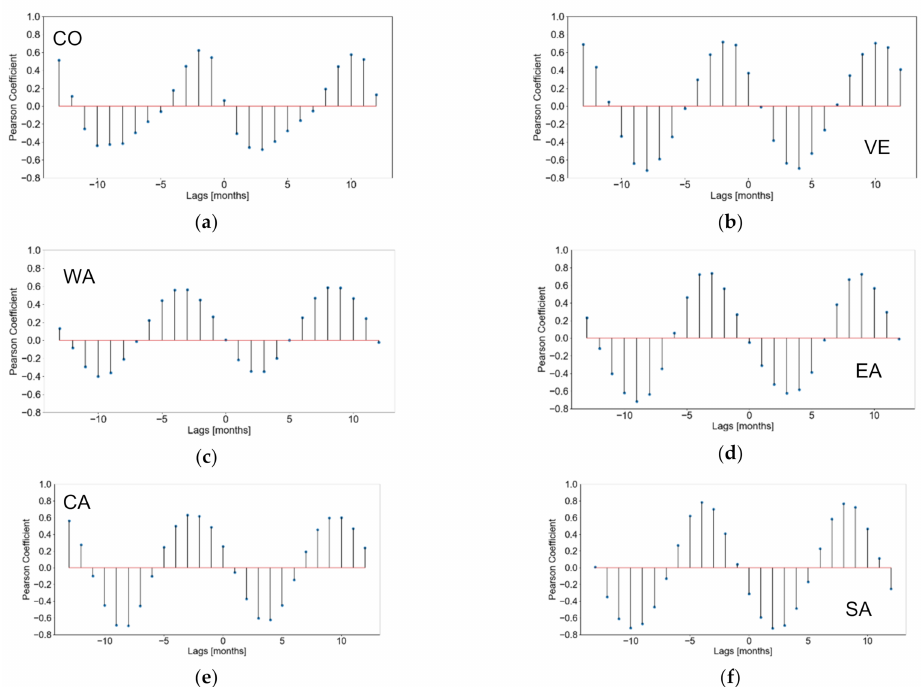
Figure 3. Lagged cross-correlations between monthly series of regionally averaged values of NDVI and SMOS over the studied regions. Negative lags denote SMOS leading NDVI, and positive lags denote NDVI leading SMOS. ( a ) CO: Colombia, ( b ) VE: Venezuela, ( c ) WA: West Amazonia, ( d ) EA: East Amazonia, ( e ) CA: Central Amazonia, and ( f ) SA: South Amazonia. Table 4. Maximum correlation coefficients between the monthly series of regionally averaged values of NDVI and SMOS, and corresponding time lags (months), for the study regions. SMOS Leads NDVI NDVI Leads SMOS Region Max. Time-Lag Max. Time-Lag Correlation (Months) Correlation (Months) CO 0.62 a − 2 0.57 a 10 VE 0.72 a − 2 0.70 a 10 WA 0.56 a − 3 0.59 a 8 CA 0.75 a − 3 − 0.78 a 8 SA 0.78 a − 4 0.76 a 9 EA 0.74 a − 3 0.72 a 9 Significance levels: (a)